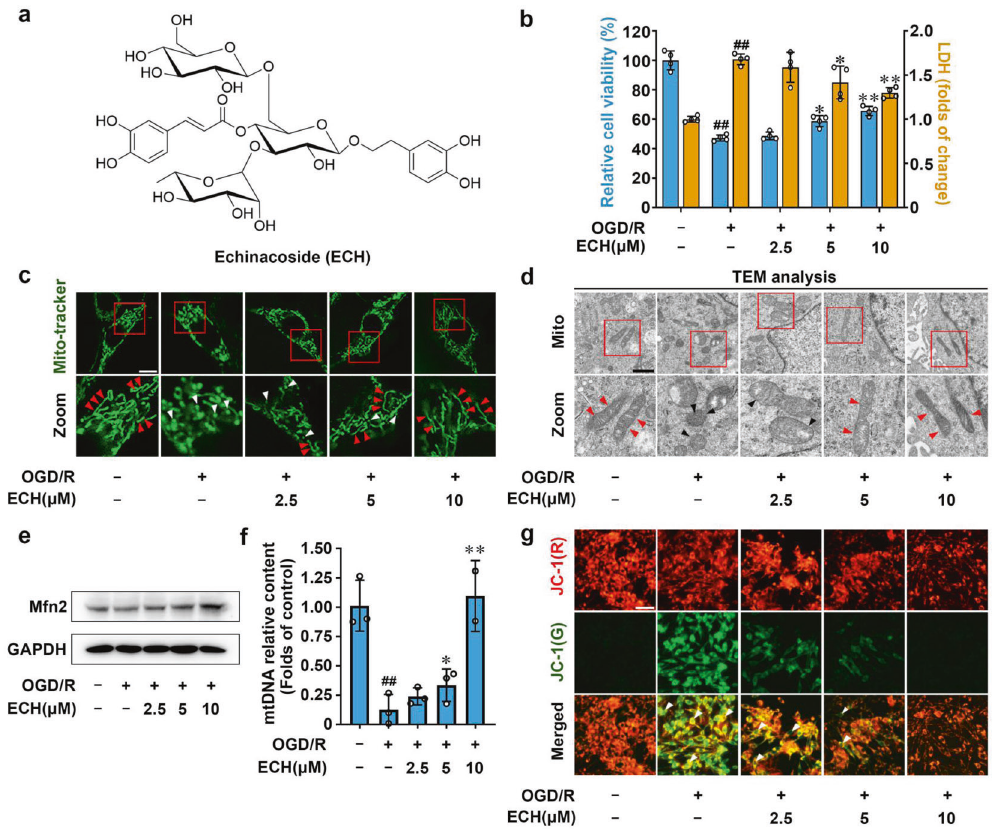
Fig. 1 Small-molecule ECH exerts neuroprotection via promoting mitochondrial fusion. a Chemical structure of echinacoside (ECH). b ECH increased cell viability and decreased LDH release against OGD/R-induced injury in PC12 cells. c ECH promoted mitochondrial fusion against OGD/R insult in PC12 cells. Arrows (red) indicate branched healthy mitochondria. Arrows (white) indicate spherical dysfunctional mitochondria (scale bar: 20 μ m). d ECH reversed the fragmented mitochondria by promoting mitochondrial fusion, which was analyzed by transmission electron microscopy (TEM). Arrows (red) indicate healthy mitochondria. Arrows (black) indicate damaged mitochondria (scale bar: 0.5 μ m). e ECH (10 μ M) increased Mfn2 protein expression, which was analyzed by western blot. f ECH increased mitochondrial DNA (mtDNA) content against OGD/R-induced injury. g ECH blocked OGD/R-induced decrease in mitochondrial membrane potential (MMP), which was detected by JC-1 staining. Arrows indicate depolarized mitochondria (scale bar: 100 μ m). Data are expressed as the mean ± SD. ## P < 0.01 vs. control group, * P < 0.05, ** P < 0.01 vs. OGD/R